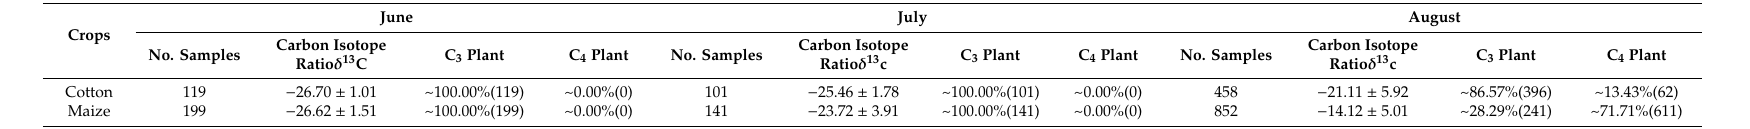
Table 2. Estimated proportion of diet for Propylea japonica adults originating from C 3 (cotton) and C 4 (maize) plants at a regional landscape composed of cotton and maize in 2013. The carbon isotope ratio δ 13 Cdata are shown as the mean ±